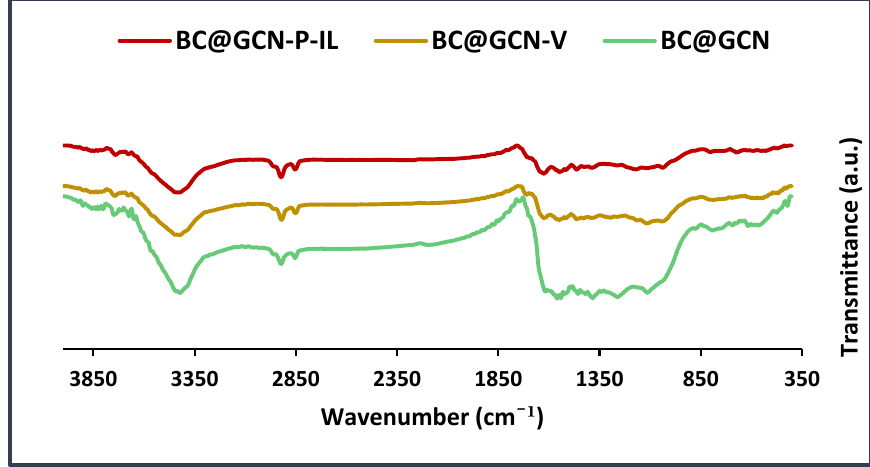
Figure 6. FTIR spectra of BC@GCN, BC@GCN-V and BC@GCN-P-IL.